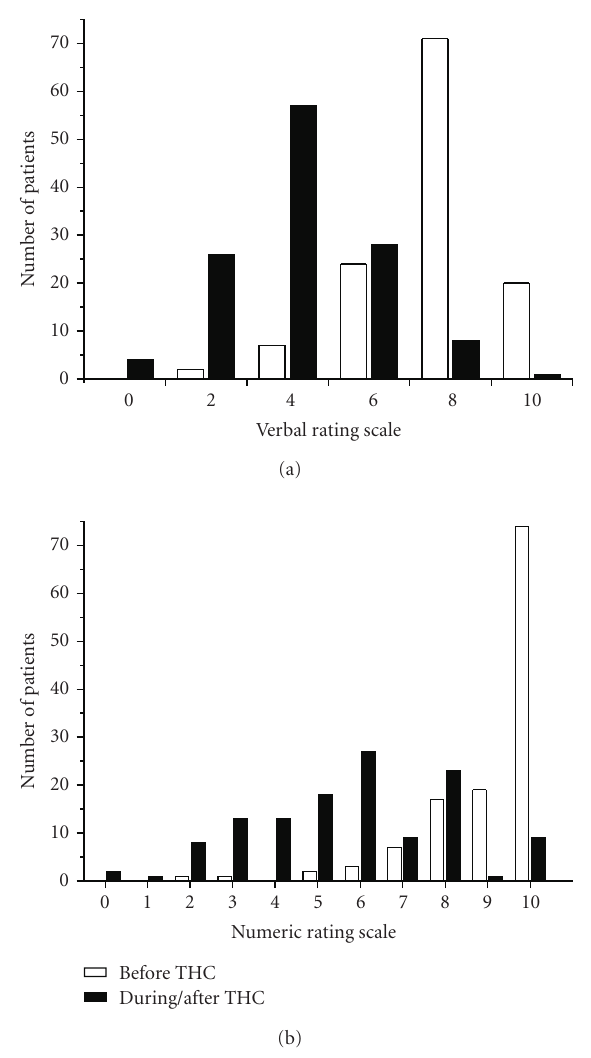
Figure 1: Number of patients and their estimation of the perceived pain intensity before (white bar) and during/after (black bar) delta 9-THC therapy by means of (a) Verbal Rating Scale (VRS) and (b) Numeric Rating Scale (NRS). Values of the VRS indicate “no pain” (0), “slight pain” (2), “moderate pain” (4), “intense pain” (6), “very strong pain” (8), “worst pain imaginable (10). The endpoints of the NRS indicate “no pain” (0) and “worst pain imaginable” (10).